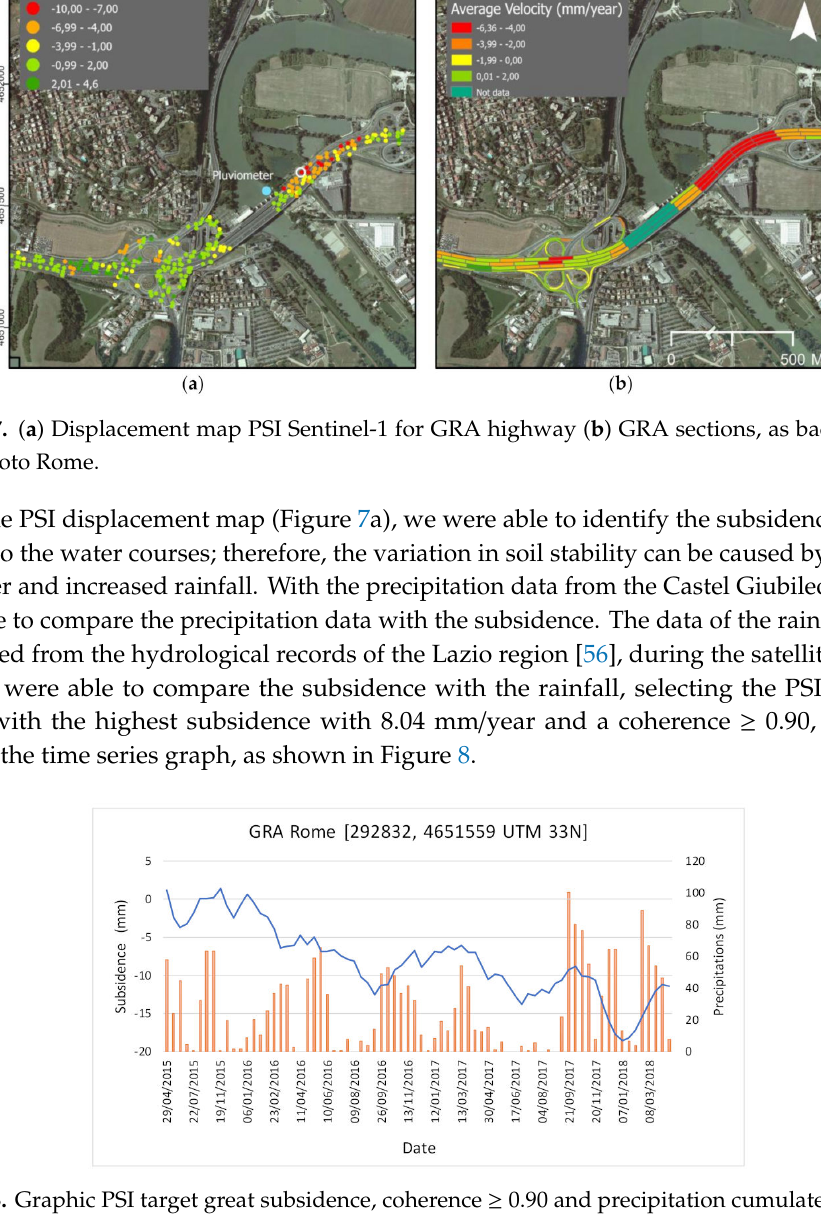
Figure 8. Graphic PSI target great subsidence, coherence ≥ 0.90 and precipitation cumulated “Castel Giubileo”